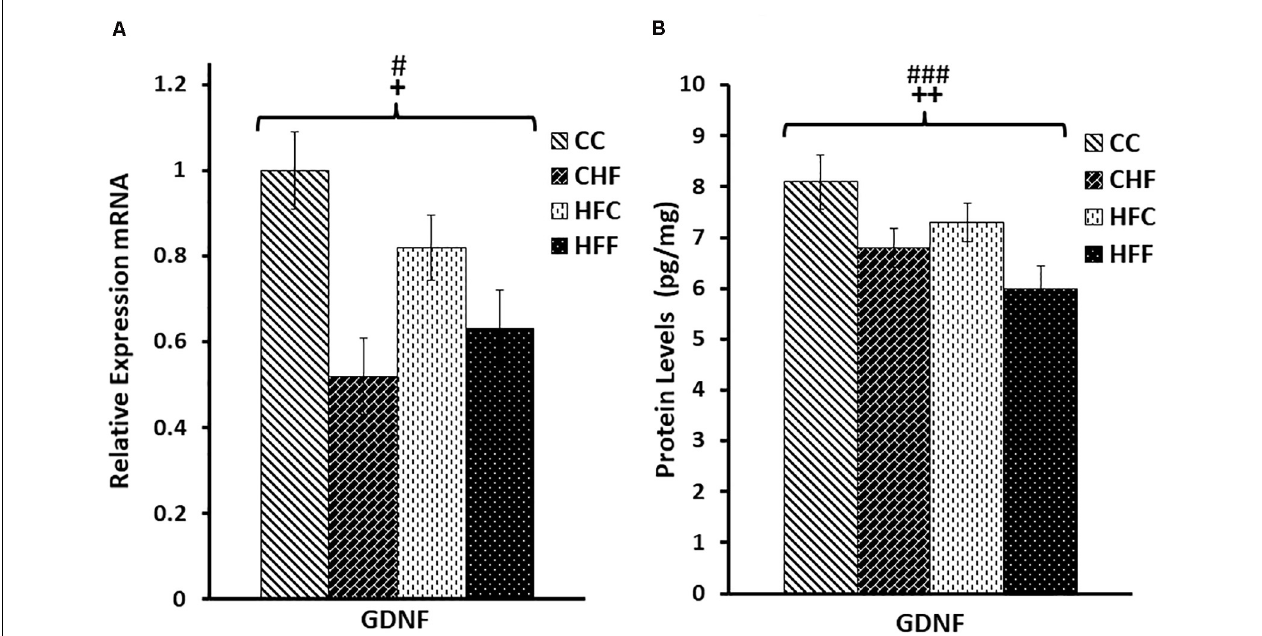
FIGURE 3 | Relative levels of GDNF mRNA and protein expression in the hippocampus. (A) Using quantitative real-time PCR (qRT-PCR), glial cell-derived neurotrophic factor (GDNF) mRNA expression was determined to be significantly reduced in response to both the maternal ( F ( 3 , 57 ) = 3.92, P = 0.049) and post-weaning HF diet ( F ( 3 , 57 ) = 4.87, P = 0.034). Values are expressed in relative units where the CC group is set to 1. (B) Significant reductions in GDNF protein levels (pg/mg) were also associated with both the maternal ( F ( 3 , 57 ) = 8.65, P = 0.004) and the post-weaning HF diet ( F ( 3 , 57 ) = 11.64, P = 0.001) using ELISA. No significant interactions were detected using two-way ANOVA. Values are means + SEM ( n = 16 for each group). + P < 0.05, ++ P < 0.01 (significant maternal diet effect); # P < 0.05, ### P < 0.001 (significant post-weaning diet